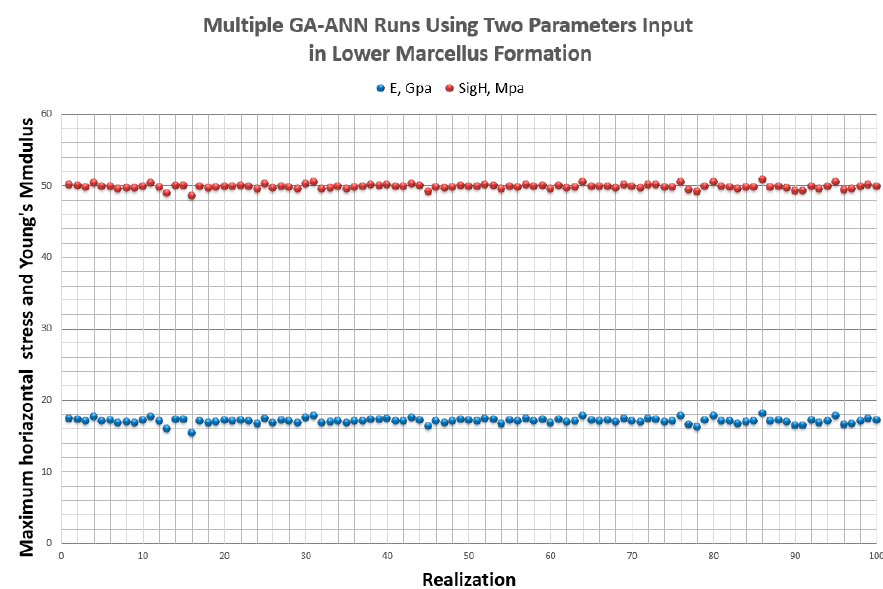
Figure 7. Results of Young’s modulus and maximum horizontal stress of 100 realizations of GA-ANN model with fixed.